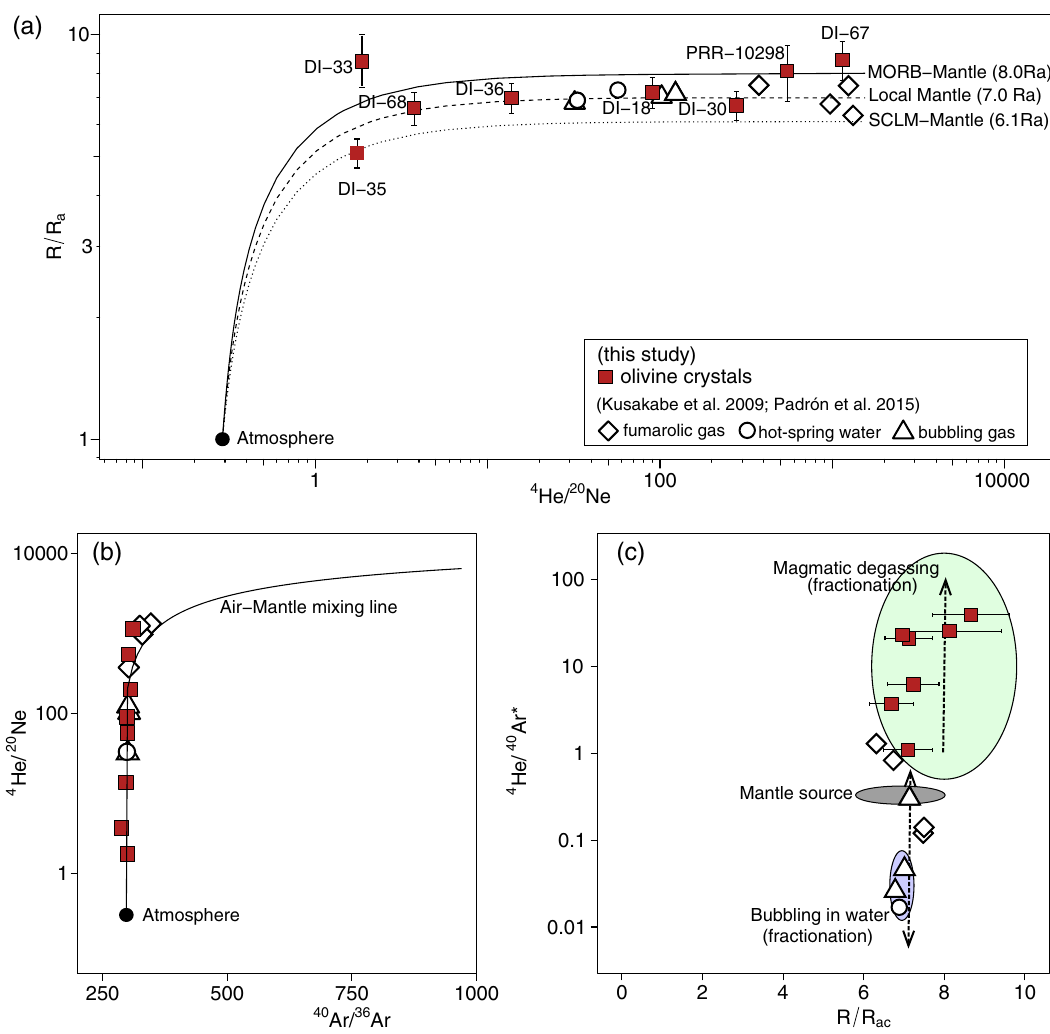
Figure 2. ( a ) 3 He/ 4 He versus 4 He/ 20 Ne diagram for Deception Island samples, showing mixing curves between low and high 4 He/ 20 Ne values of atmospheric, MORB and SCLM components (e.g., 57 ); ( b ) samples with the lowest 4 He/ 20 Ne values also have lowest 40 Ar/ 36 Ar values indicative of air contamination (see text and Table 1 for more details); ( c ) 4 He/ 40 Ar * versus 3 He/ 4 He highlighting the mantle source area and the two main fractionation fields, i.e., magmatic degassing and bubbling in the waters (dashed arrows). Fumaroles and hot spring samples shift from the mantle source value (2–5) to (i) higher values due to magma degassing (as the olivines), and (ii) to lower values by fractionation during degassing from magma or dissolving in water followed by bubbling. Note that the noble gas isotopic ratios from the olivine crystals are plotted together with those from fumaroles and hot spring waters, which already represent fractionated noble gas elemental